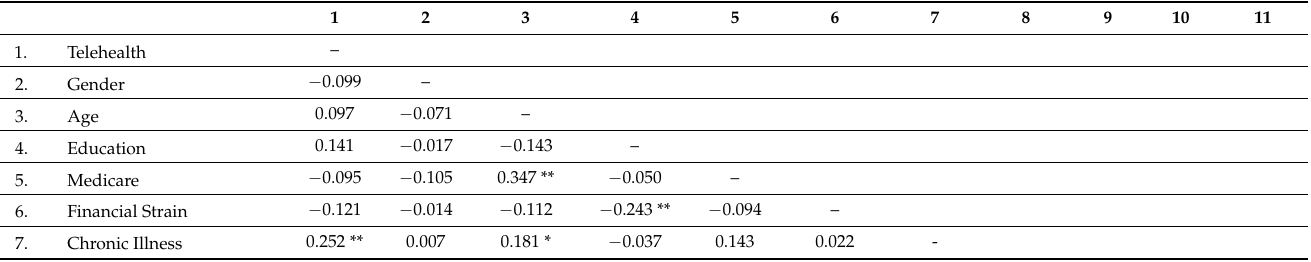
Table 2. Bivariate correlations between telehealth utilization and other study